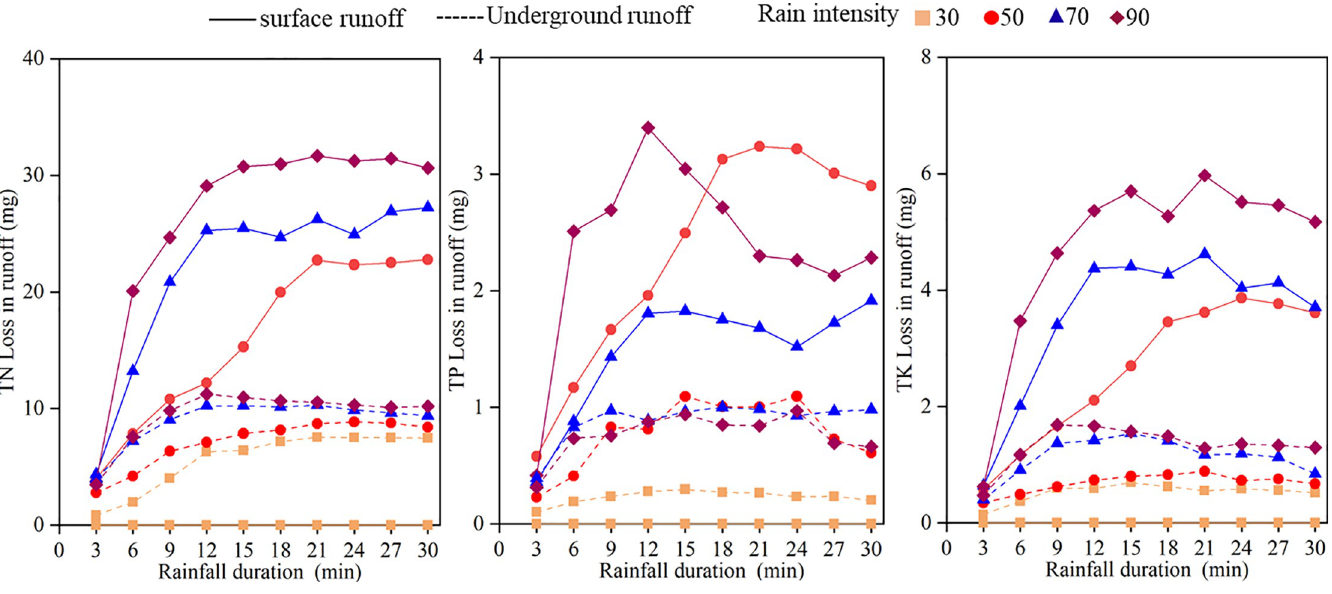
Fig 7. Variation of runoff nutrient and diversion loss with rainfall